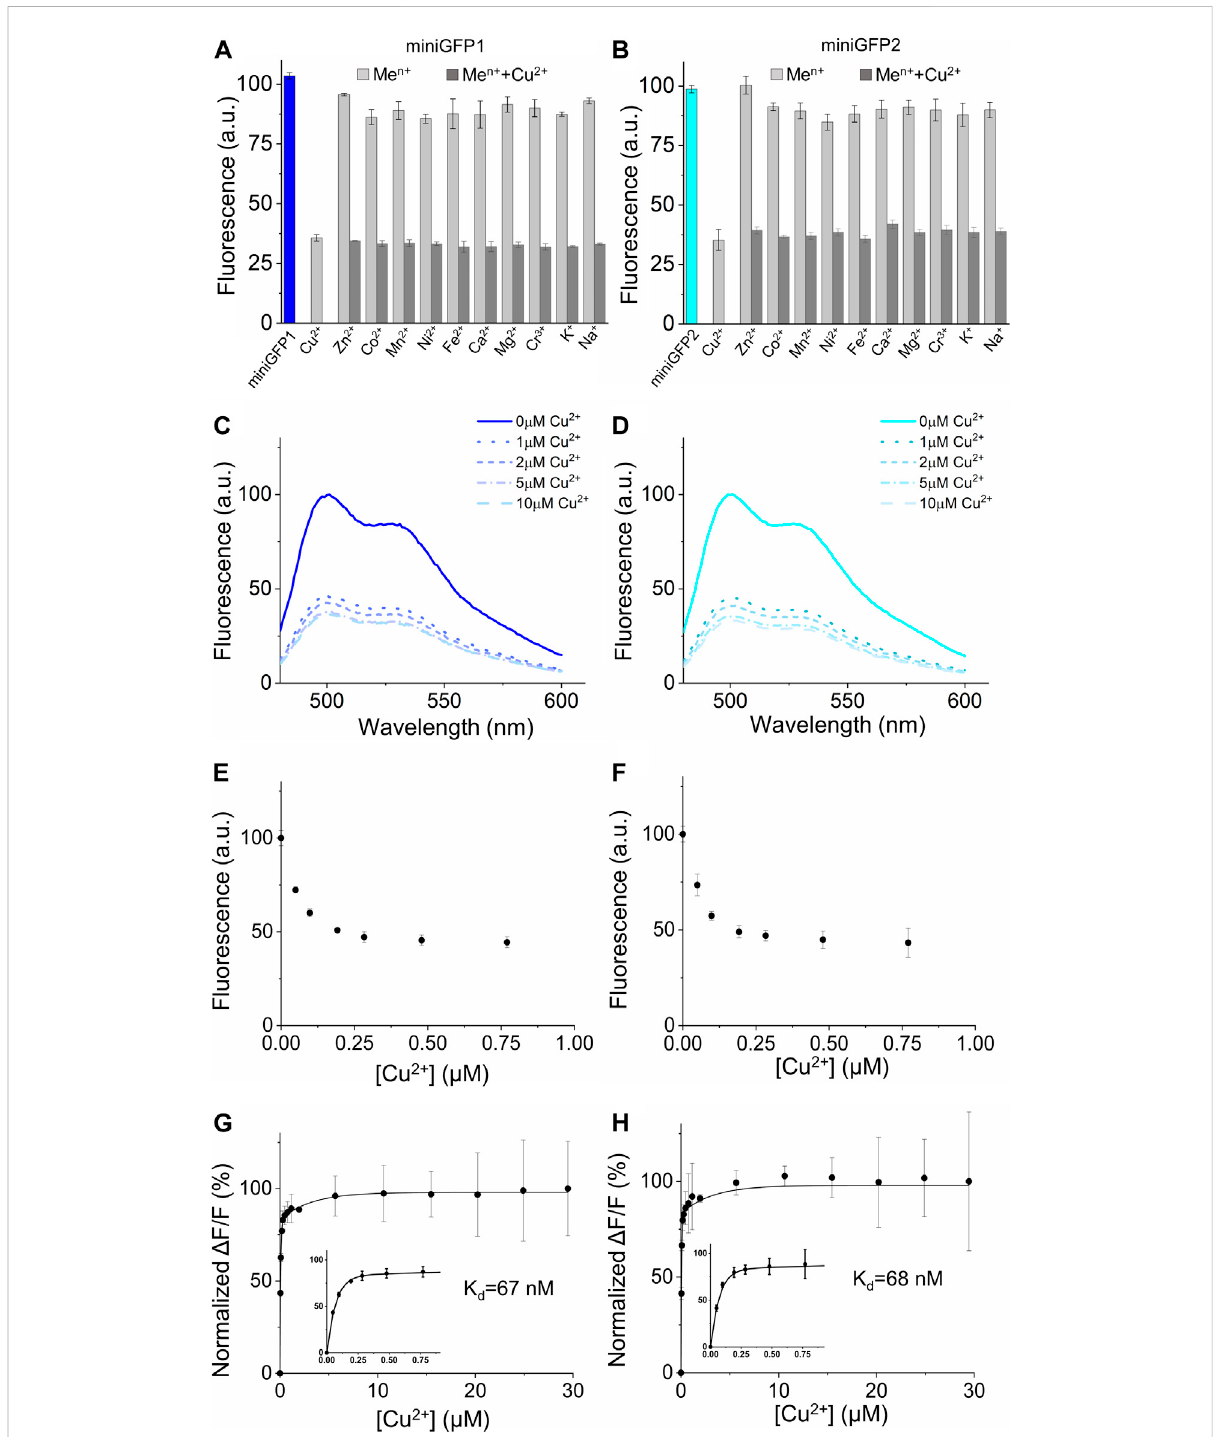
FIGURE 6 MetalsensitivityofminiGFPsinsolution. (A,B) Selectivityandspeci fi cityofminiGFP1andminiGFP2toCu 2+ andotherselectedmetalcations( n = 3technical replicates each; column, mean, error bars, standard deviation). Data are normalized to the fl uorescence intensity at ions-free conditions, pH 7.4. The measurements were performed at 100 μ M for Cu 2+ , Zn 2+ , Co 2+ , Mn 2+ , Ni 2+ , Fe 2+ , at 800 μ M for Ca 2+ , Mg 2+ , K + , Na + , and at 6 μ M for Cr 3+ . miniGFP1 is shown as blue column and miniGFP2 is shown as cyan column, other metal cations are shown as light grey column. (C,D) Fluorescencespectra ofminiGFP1 and miniGFP2with increasing Cu 2+ from 0to 10 μ M.Data are normalized tothe fl uorescence intensity at500 nm incopper-freecondition. (E,F) TitrationofminiGFP1andminiGFP2shownasintegrated fl uorescencefromplot (C,D) againstCu 2+ concentrationand normalized to initial fl uorescence intensity. (G,H) The binding af fi nity curves of miniGFP1 and miniGFP2, the concentration range of the 0 – 0.75 μ M Cu 2+ are shown in the inset. Dots represent mean, error bars represent standard deviation for 3 technical replicates